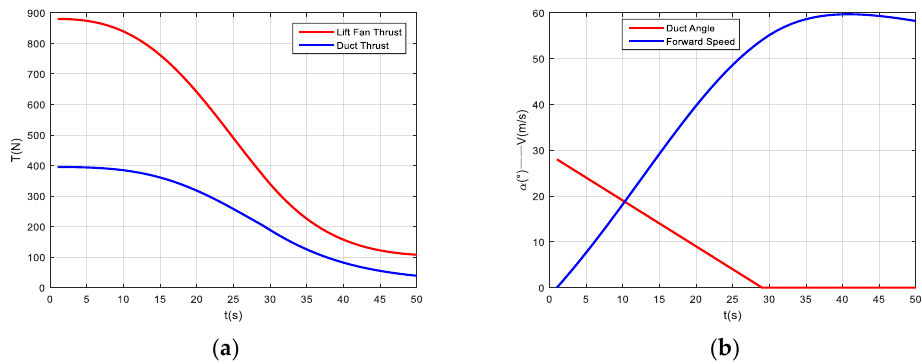
Figure 13. ( a ) Deflection grille slow transition of lift fan and lift duct thrust state; ( b ) Deflection grille slow transition of forward speed and lift duct deflection.